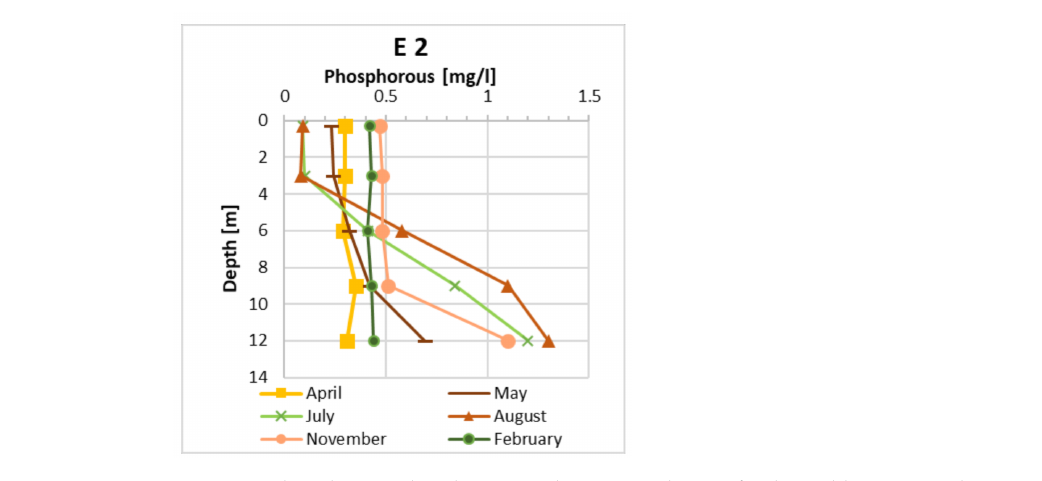
Figure 5. Phosphorous distribution in the water column of Lake Eichbaumsee at location E2 between April 2018 and February 2019.